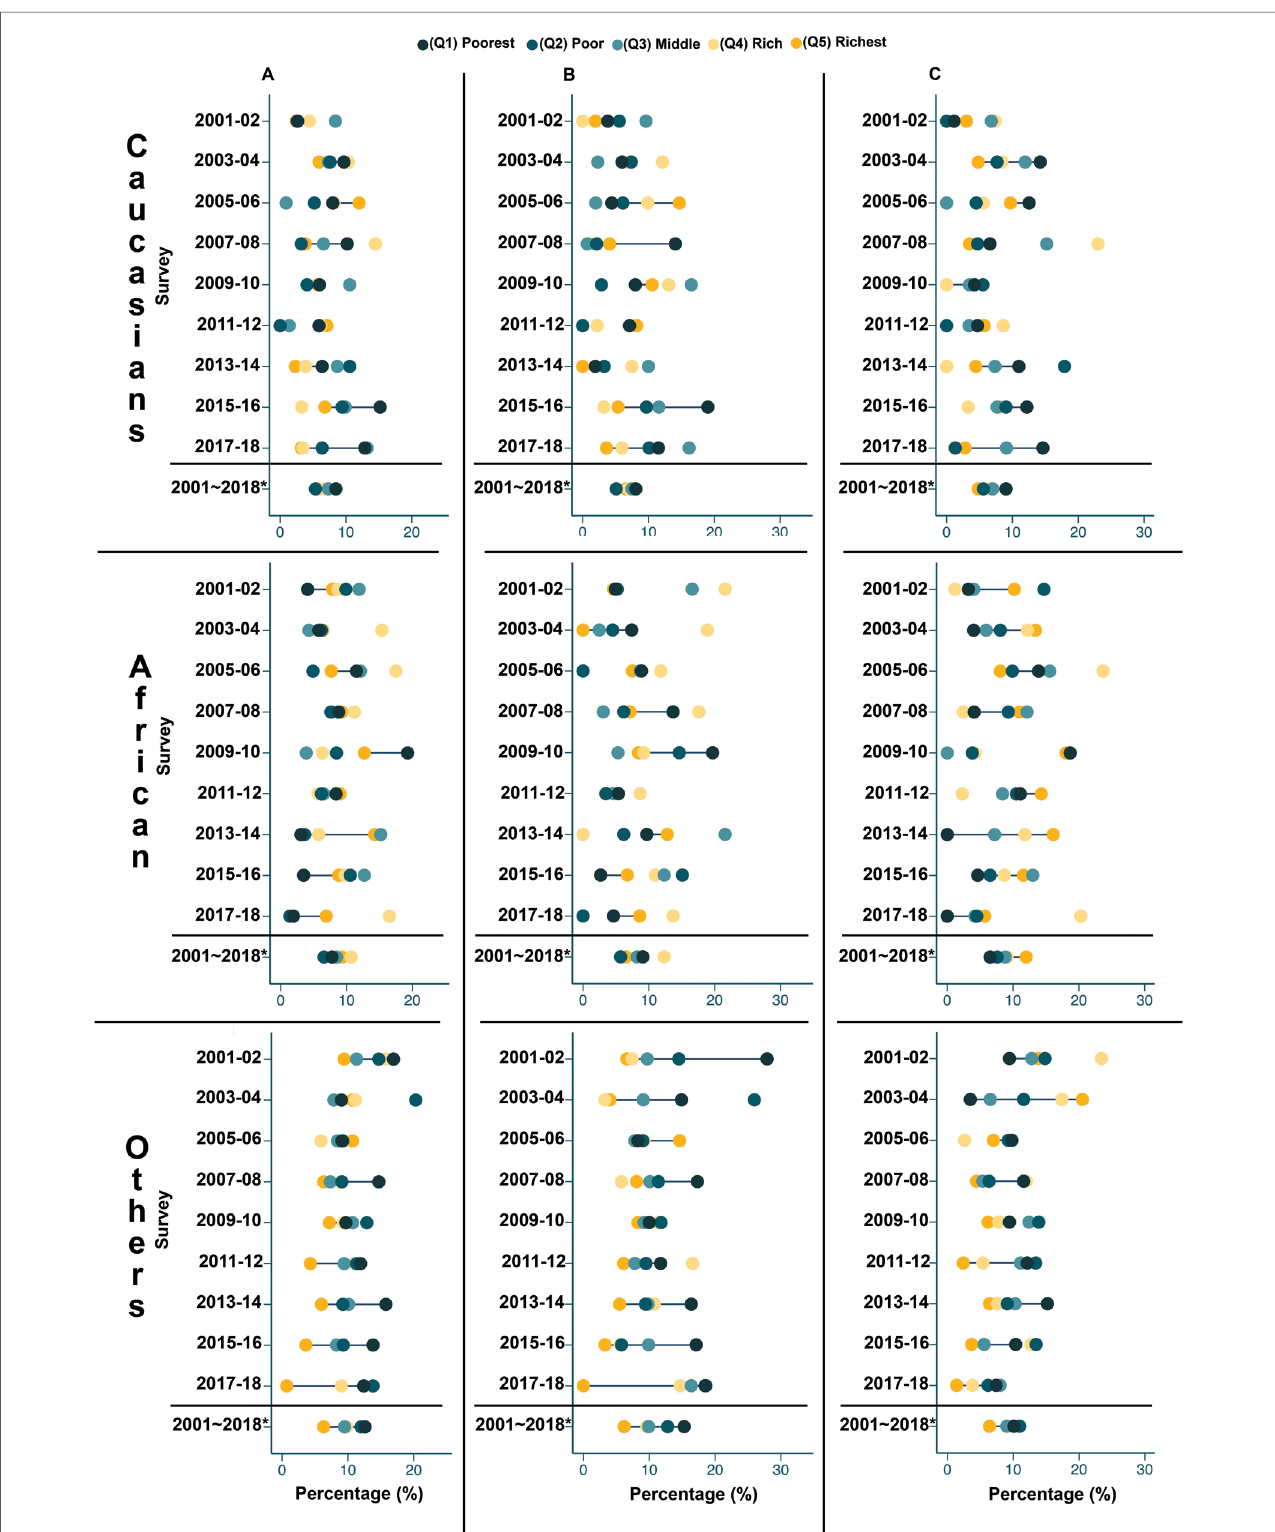
FIGURE 2 Prevalence of overweight/obesity by wealth quintile, for each survey year and for pooled data. Caucasian: Caucasian, African: African American, Others: other ethnicities, Overall: All children from the same ethnic group gathered. (Q1): Quintile 1, (Q2): Quintile 2, (Q3): Quintile 3, (Q4): Quintile 4, (Q5): Quintile 5. A: Overall, B: Male, C: Female